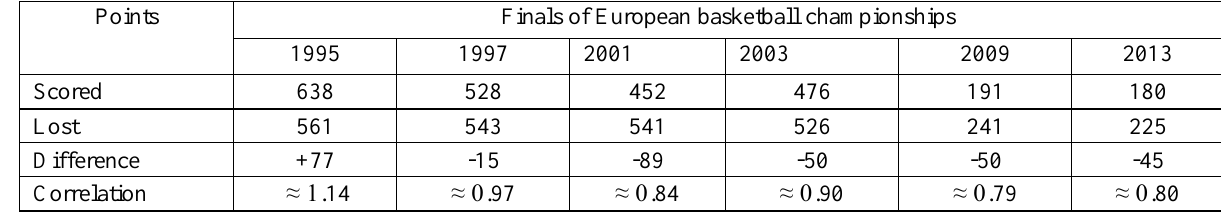
Scored and lost points of basketball combined team of Ukraine (women) in finals of European championships 1995-